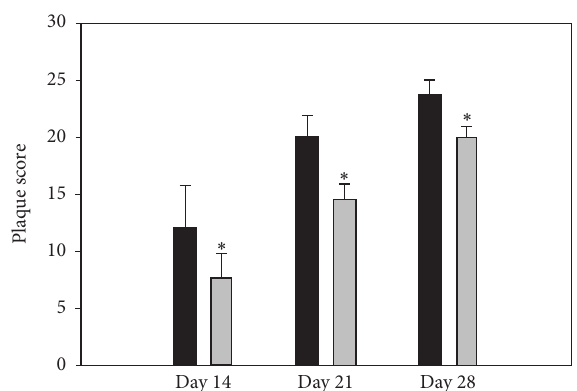
Figure 1: Plaque score (the sum of plaque index and plaque thickness on all assessed teeth in the mouth) in dogs in the control trial and in dogs using the oral care product (OCP). Black bars denote control dogs and grey bars denote OCP dogs. There was a significant increase in plaque score within group by each assessment day. Numbers of dogs (control, treatment): day 14: 6, 11; day 21: 9, 14; day 28: 11, 15. ∗ indicates significant difference between treatments ( 𝑝 ≤ 0.05 ).